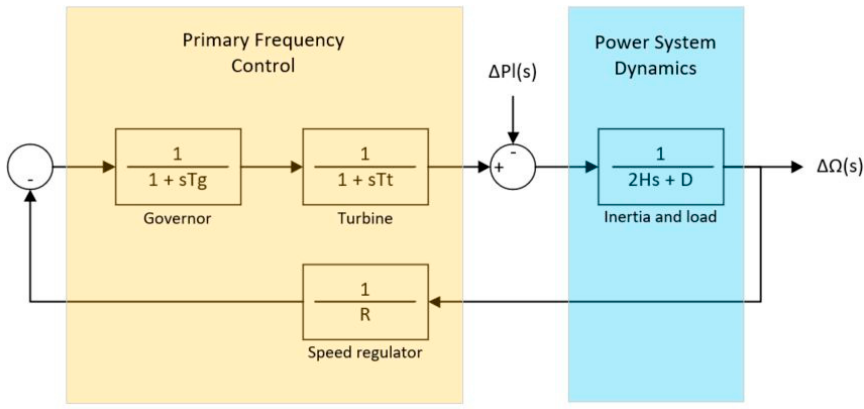
Figure 9. Primary frequency control scheme used for simulations [3].